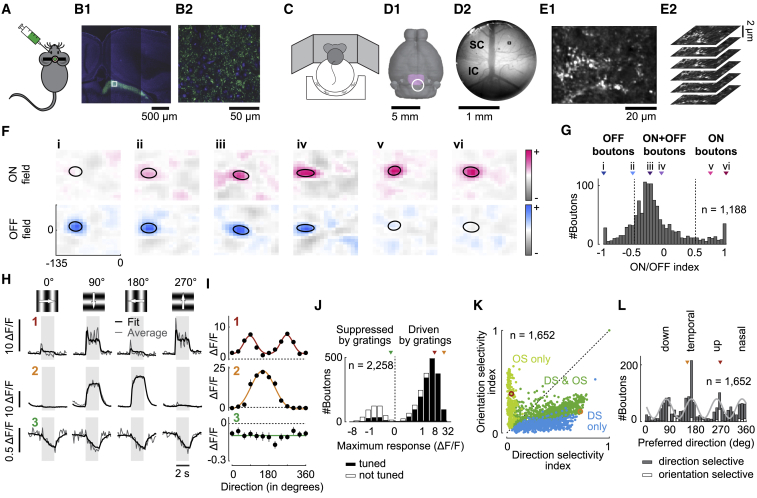
Visual Responses of Retinal Boutons Imaged in SC(A) SyGCaMP6f is injected into one eye.(B) Confocal images showing expression of SyGCaMP6f in synaptic boutons in the contralateral SC.(C) Mice were head-fixed on a treadmill surrounded by three monitors.(D) Positioning of the implant (circle) over superior colliculus (SC; purple), view through the implant showing SC and inferior colliculus (IC), and field of view of a typical two-photon imaging session of retinal boutons (rectangle).(E) Average frame of one two-photon imaging session (E1). Planes were imaged with 2-μm spacing to track boutons even during brain movements (E2).(F) Receptive fields of six boutons (i–vi), mapped with sparse sequences of white and black squares. Positions are in visual degrees relative to the front of the mouse and the height of the eyes. Ellipses outline the receptive fields at half height.(G) Distribution of ON/OFF indices across all boutons. For ease of description, we defined boutons as “ON” if their ON/OFF index was >0.5, “OFF” if it was <−0.5, and “ON+OFF” if it was intermediate. Triangles show ON/OFF indices of examples in (F).(H) Average (gray) and fitted (black) calcium responses of three boutons (1–3) in response to four sinusoidal gratings drifting in four directions. Gray shades show the times of stimulus presentation.(I) Direction tuning (mean ± SEM) and fitted tuning curves (solid lines) of the three boutons in (H) in trials where the pupil was small.(J) Distribution of maximum amplitudes in response to gratings across boutons. Boutons that are suppressed by gratings have negative maxima. Black bars represent boutons that are tuned to direction; white bars represent boutons that are not tuned. Triangles show maximum responses of examples in (H) and (I).(K) Orientation and direction selectivity indices of boutons that are selective only for orientation (light green), only for direction (blue), or for both orientation and direction (dark green). Circles show examples 1 and 2 in (H) and (I).(L) Distribution of preferred directions of boutons that are direction selective (gray bars) or only orientation selective (white bars). Fourth harmonic (light gray line) was fit using Fourier decomposition. Triangles show examples 1 and 2 in (H) and (I).